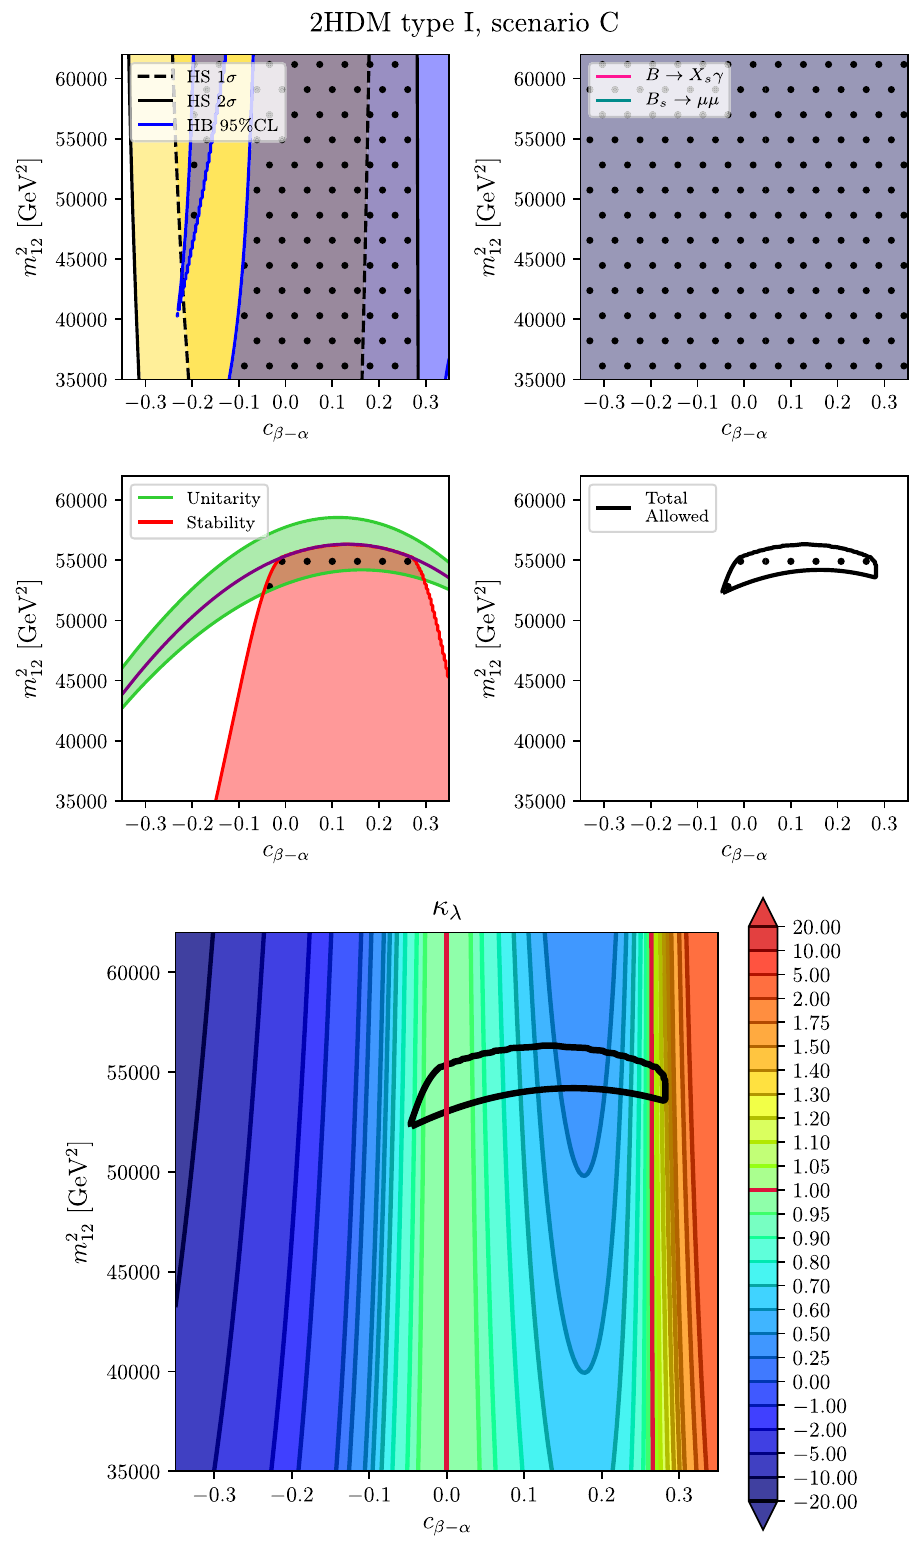
) plane for m = m = m = 650 GeV and tan β = H A H ± 12 = ( m 2 cos 2 α)/( tan H 12